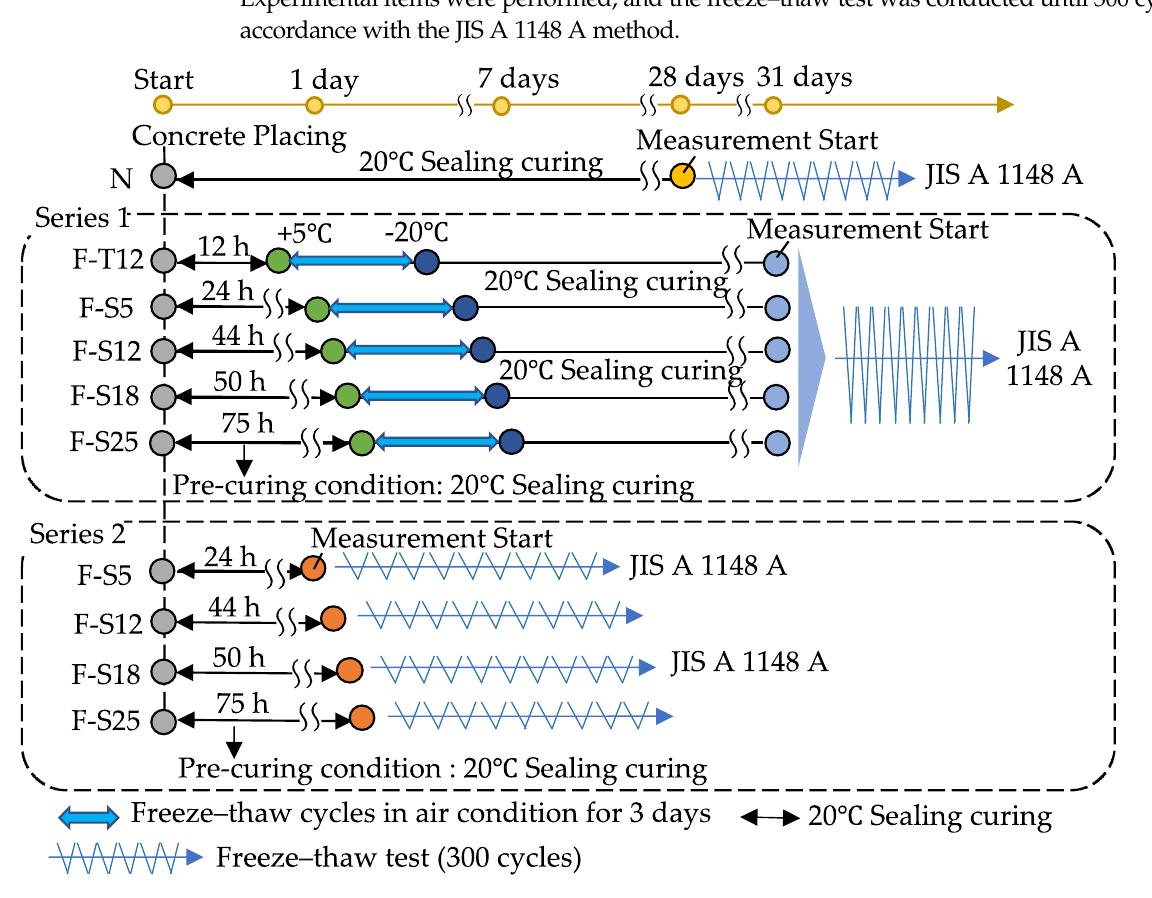
Figure 1. Flowchart of the main experiments.